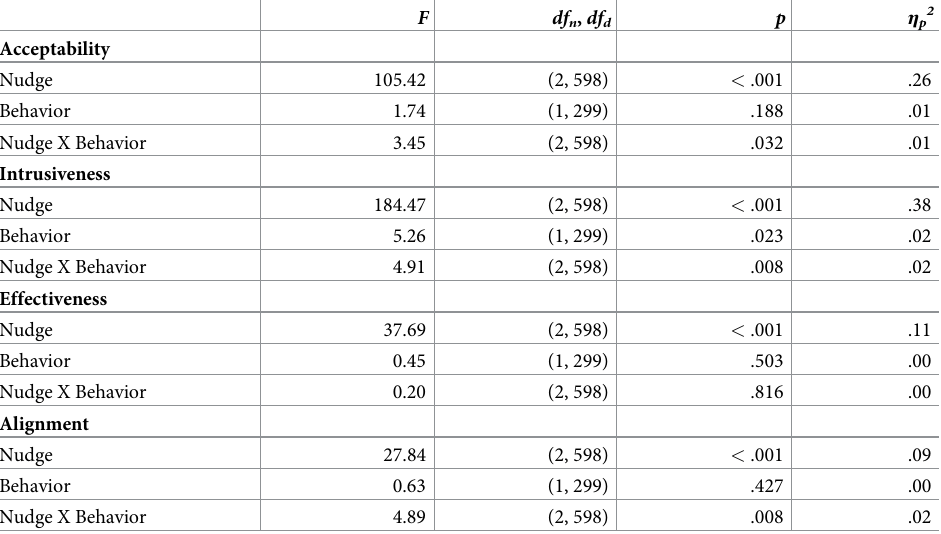
Table 4. Mixed ANOVAs predicting acceptability, intrusiveness, effectiveness and goal alignment. F df n , df